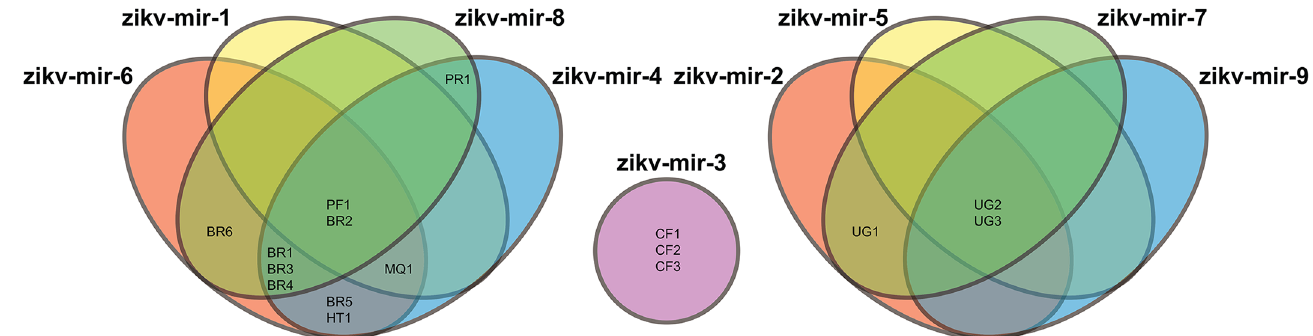
Fig 2. Venn diagram showing the nine different types of miRNAs predicted to be encoded by all analyzed ZIKV genomes. Brazil (BR); Central African Republic (CF); French Polinesia (FP); Haiti (HT); Martinique (MQ); Puerto Rico (PR); Uganda (UG).